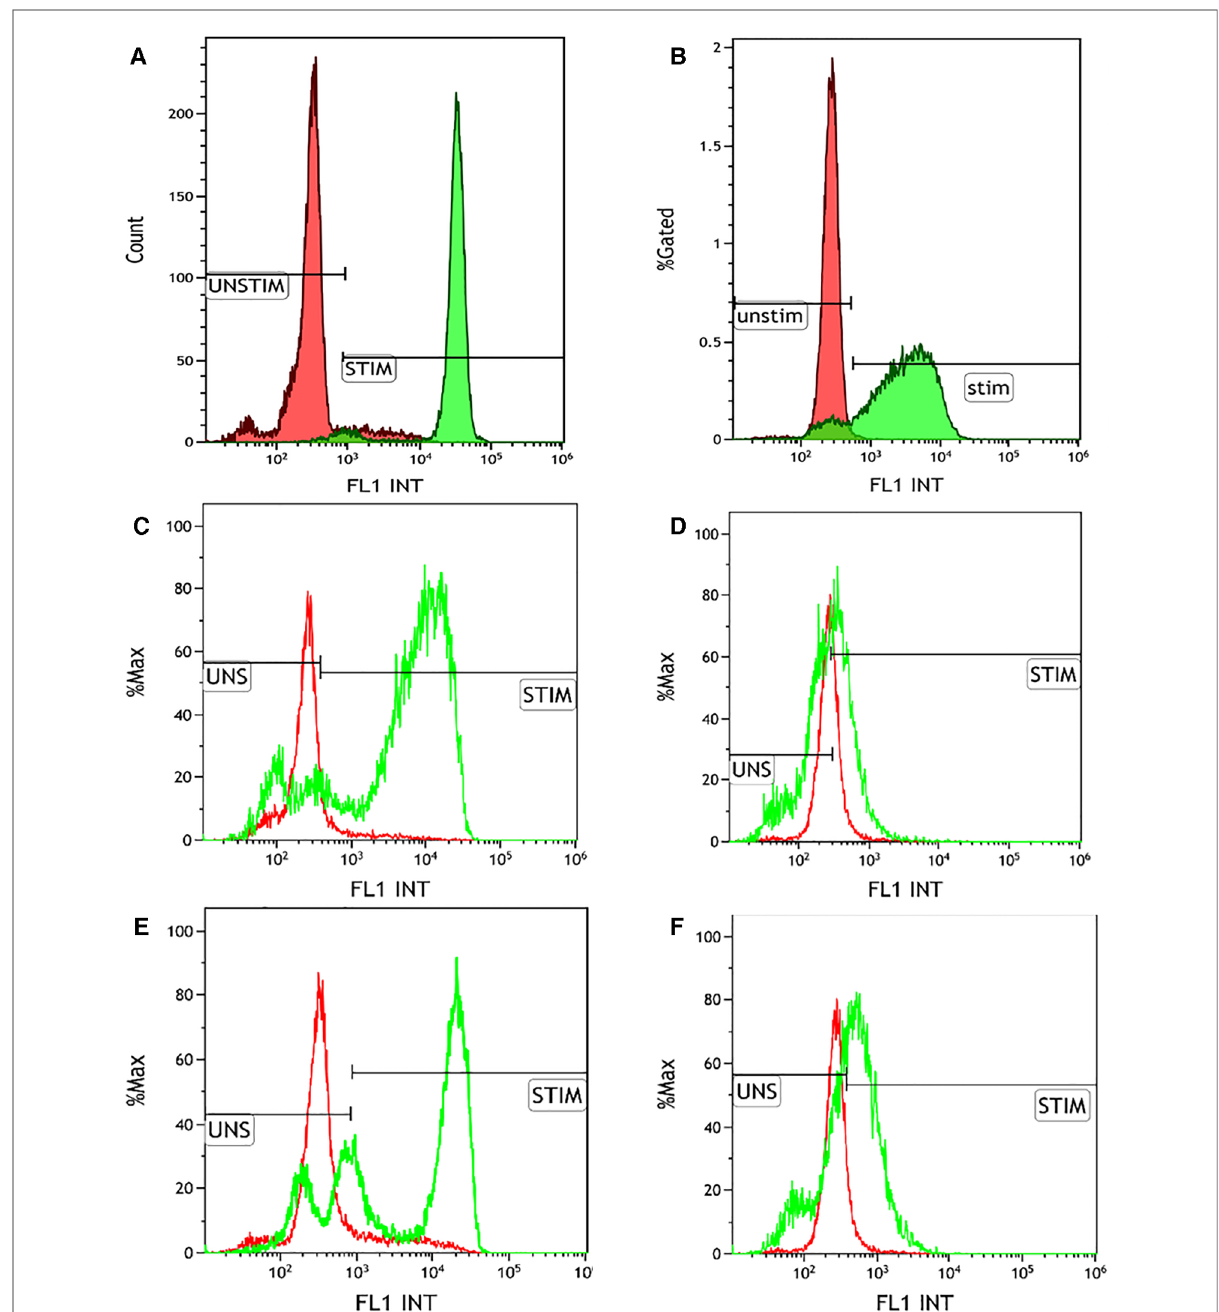
FIGURE 2 Dihydrorhodamine (DHR) test using multiple stimulants. ( A ) Healthy control showing normal right shift of the neutrophils stimulated by phorbol myristate acetate (100 ng/mL) (MFI of unstimulated and stimulated neutrophils is 319.68 and 32605.18, respectively; S.I. of 101.99; % positivity of the stimulated neutrophils 97.16%); ( B ) DHR plot of the patient showing stunted broad-based peak of the PMA-stimulated neutrophils (MFI of unstimulated and stimulated neutrophils is 272.29 and 3116.69, respectively; S.I. of 11.44; % positivity of the stimulated neutrophils 88.7%); ( C ) Healthy control showing normal right shift of the neutrophils stimulated by Escherichia coli (OD600-0.1) (MFI of unstimulated and stimulated neutrophils is 299.9 and 27464.1, respectively; S.I. of 91.57; % positivity of the stimulated neutrophils 87.44%); ( D ) DHR plot of the patient showing absent right shift of the E. coli stimulated neutrophils (MFI of unstimulated and stimulated neutrophils is 245.57 and 477.52, respectively; S.I. of 1.94; % positivity of the stimulated neutrophils 13.67%); ( E ) Healthy control showing normal right shift of the neutrophils stimulated by Staphylococcus aureus (OD600-0.1) (MFI of unstimulated and stimulated neutrophils is 299.9 and 20631.91, respectively; S.I. of 68.79; % positivity of the stimulated neutrophils 69.7%); ( F ) DHR plot of the patient showing absent right shift of the S. aureus stimulated neutrophils (MFI of unstimulated and stimulated neutrophils is 245.57 and 987.59, respectively; S.I. of 4.02; % positivity of the stimulated neutrophils